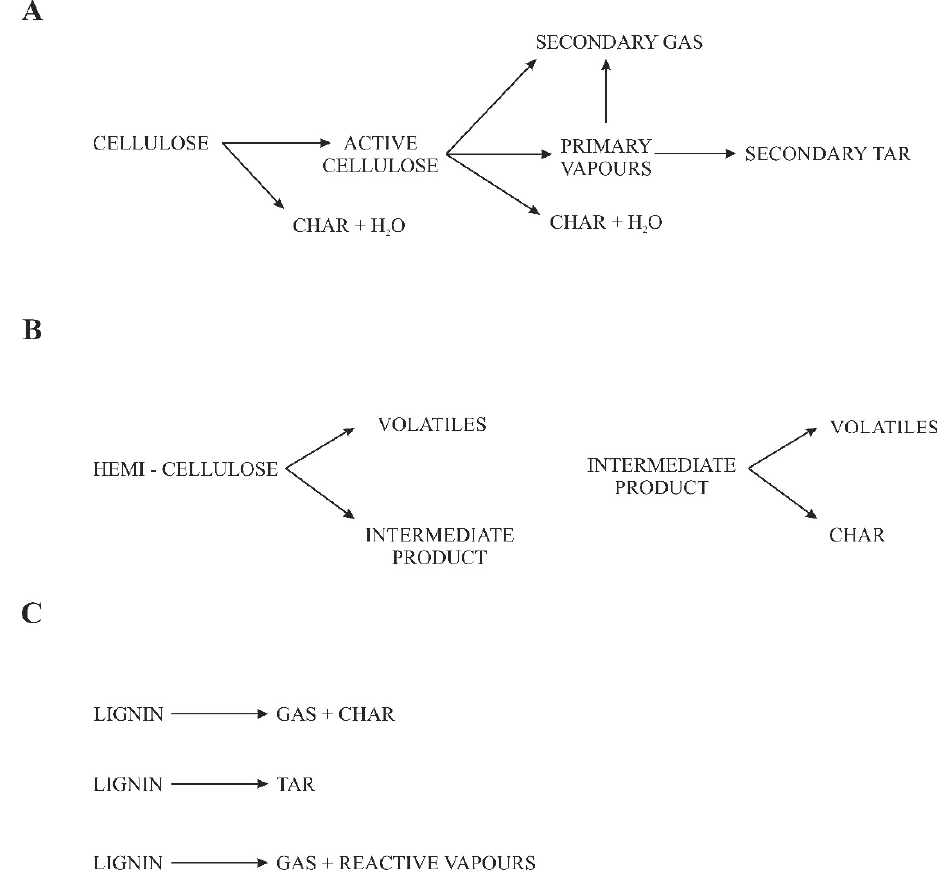
Figure 1. Decomposition mechanism of ( A ) cellulose, ( B ) hemicellulose, and ( C ) lignin (own elabora- tion from [22,23]).